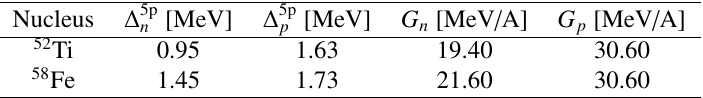
Table 1. The monopole pairing strengths for neutrons(protons) G n ( p ) (in units MeV / A where A is the nuclear mass number), adjusted to reproduce the empirical neutron(proton) pairing gaps ∆ 5p n ( p ) calculated using the five-point formula [22] for 52 Ti and 58 Fe. Calculations are performed using the FT-HBCS with D3C ∗